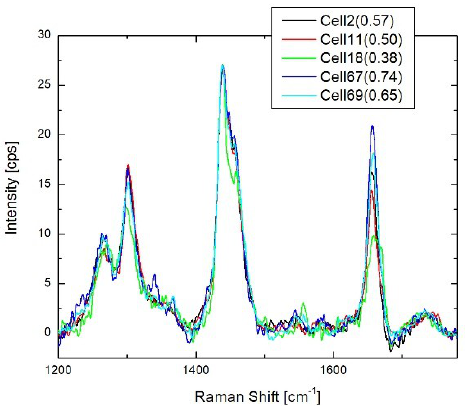
Figure 4. Spectra of endoplasmic reticulum lipids in the range 1200–1800 cm − 1 normalized to 1665 cm − 1 peak intensity. Spectra represent different live cells growing in the same dish. Numbers in parentheses show the ratio of peaks at 1665 and 1440 cm − 1 .